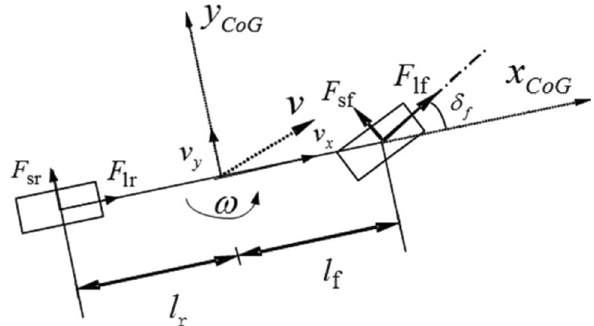
Figure 1. Vehicle single-track